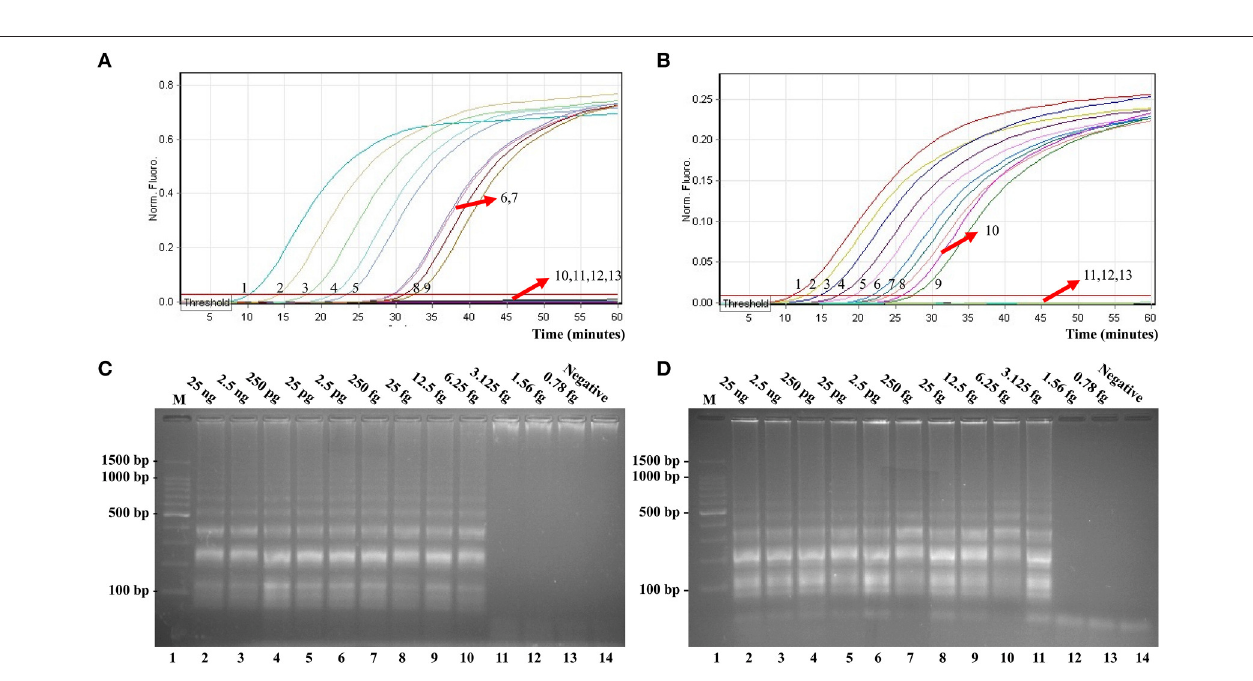
FIGURE 6 | Real-time detection of a single target in an ET-MCDA. Analytical sensitivity of Salmonella -ET-MCDA (A) and Shigella -ET-MCDA (B) for Salmonella and Shigella detection was analyzed by real-time format, and signals 1, 2, 3, 4, 5, 6, 7, 8, 9, 10, 11, 12, and 13 represent DNA levels of 25 ng, 2.5 ng, 250 pg, 25 pg, 2.5 pg, 250 fg, 25 fg, 12.5 fg, 6.25 fg, 3.125 fg, 1.56 fg, and 0.78 fg per tube and negative control. The LoD of Salmonella -ET-MCDA approach was 6.25 fg per tube, and the Shigella -ET-MCDA for 3.125 fg per tube. Analytical sensitivity of Salmonella- ET-MCDA (C) and Shigella -ET-MCDA (D) for Salmonella and Shigella detection